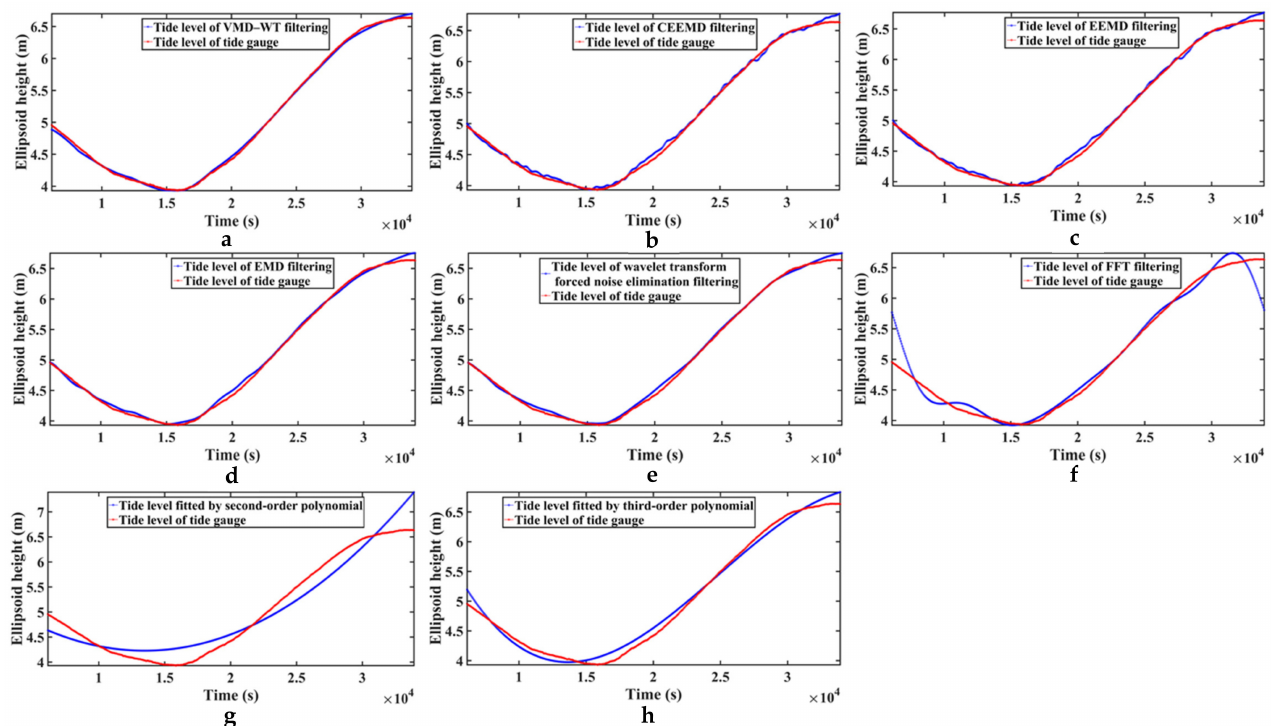
Figure 15. Comparison between the tide level of geodetic height extracted by eight filtering methods and the tide level of tide gauge for 7.7 h. ( a ) Tide level of VMD–WT filtering and the tide gauge; ( b ) Tide level of CEEMD filtering and the tide gauge; ( c ) Tide level of EEMD filtering and the tide gauge; ( d ) Tide level of EMD filtering and the tide gauge; ( e ) Tide level of wavelet transform forced noise elimination filtering and the tide gauge; ( f ) Tide level of FFT filtering and the tide gauge; ( g ) Tide level of second-order polynomial fit and the tide gauge; ( h ) Tide level of third-order polynomial fit and the tide